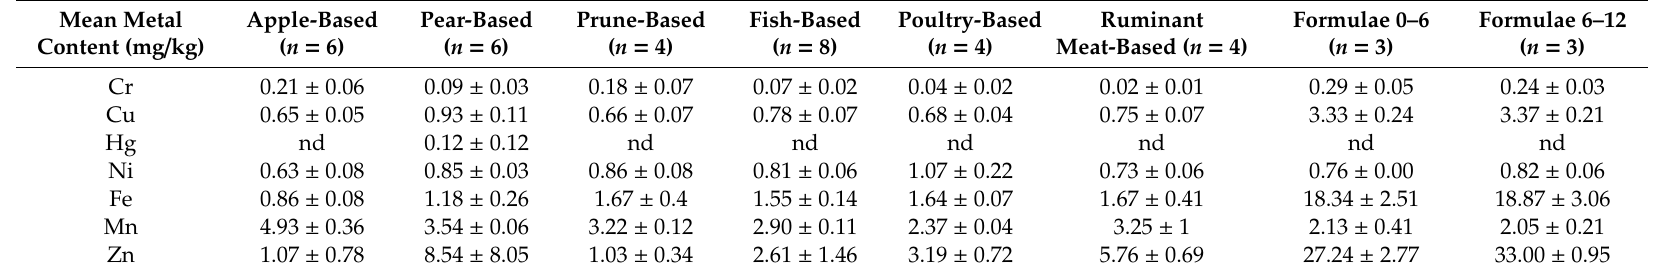
Table 3. Metal content (mg / kg) in infant foods and